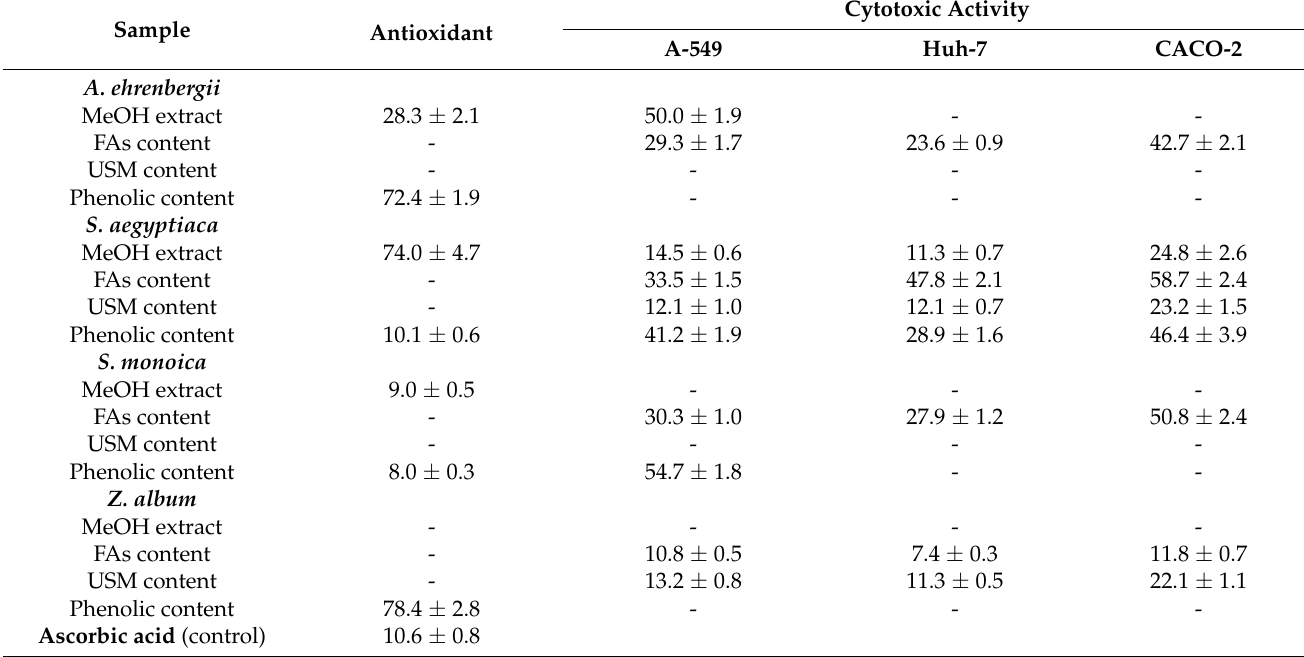
Table 6. Antioxidant and cytotoxic activities (IC 50 µ g/mL, n = 3) of the halophytic MeOH extracts and lipoidal and phenolic